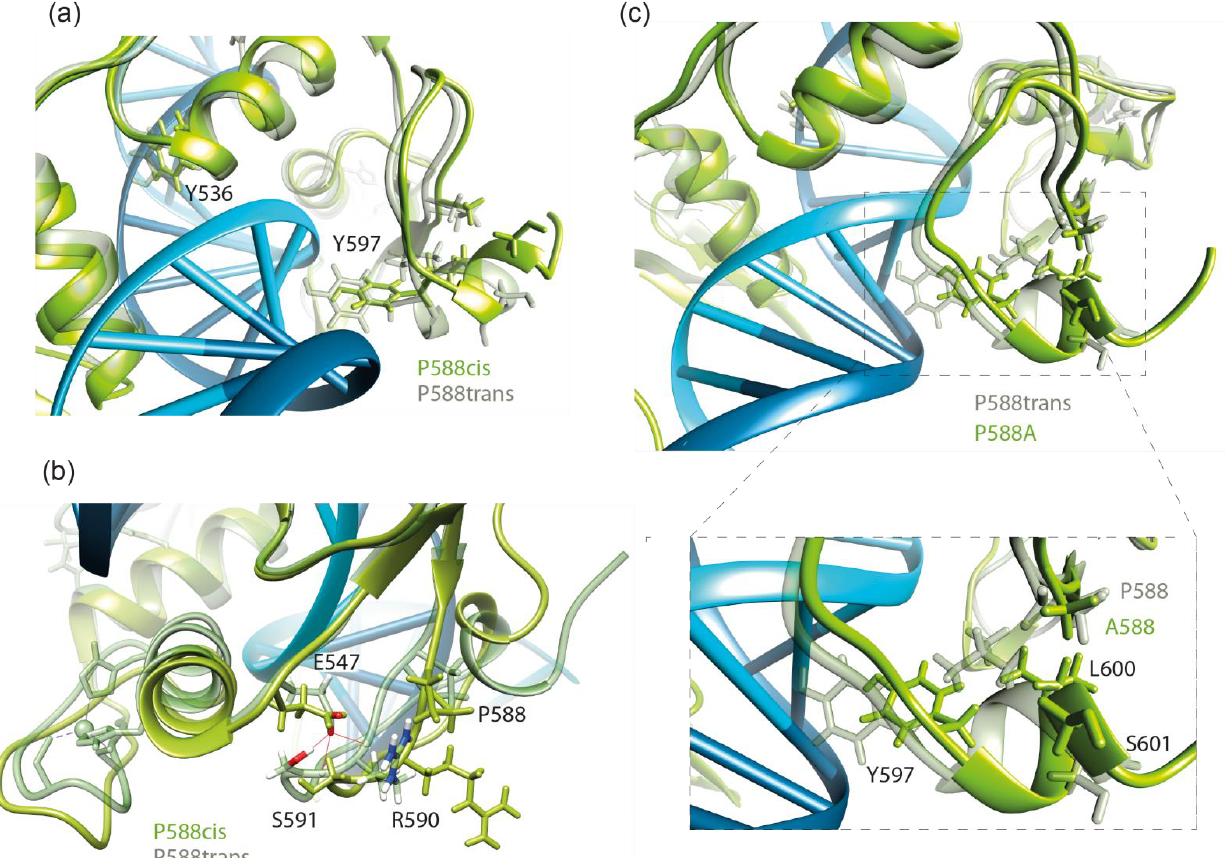
Figure 4. ( a ) The view of changes in the conformation of the Y536 and Y597 residues forming hydrogen bonds with DNA upon P588 cis isomerization at the end of a 100 ns molecular dynamics simulation. ( b ) The presence of the E547-R590/S591 hydrogen bond along molecular dynamics trajectories of wild-type and P588 cis Kaiso complexes with Kaiso binding sequence DNA. ( c ) The overlay of wild-type and P588A-substituted Kaiso – DNA complexes. The position of the P588-L600 hydrophobic contact is shown. Table 1. The presence of the E547-R590/S591 hydrogen bond along last 90 ns of 100 ns molecular dynamics trajectories of Kaiso complexes with Kaiso binding sequence and methylated DNA. Grey fill indicates H-bonds weakened 5× times or more compared to wild-type protein.